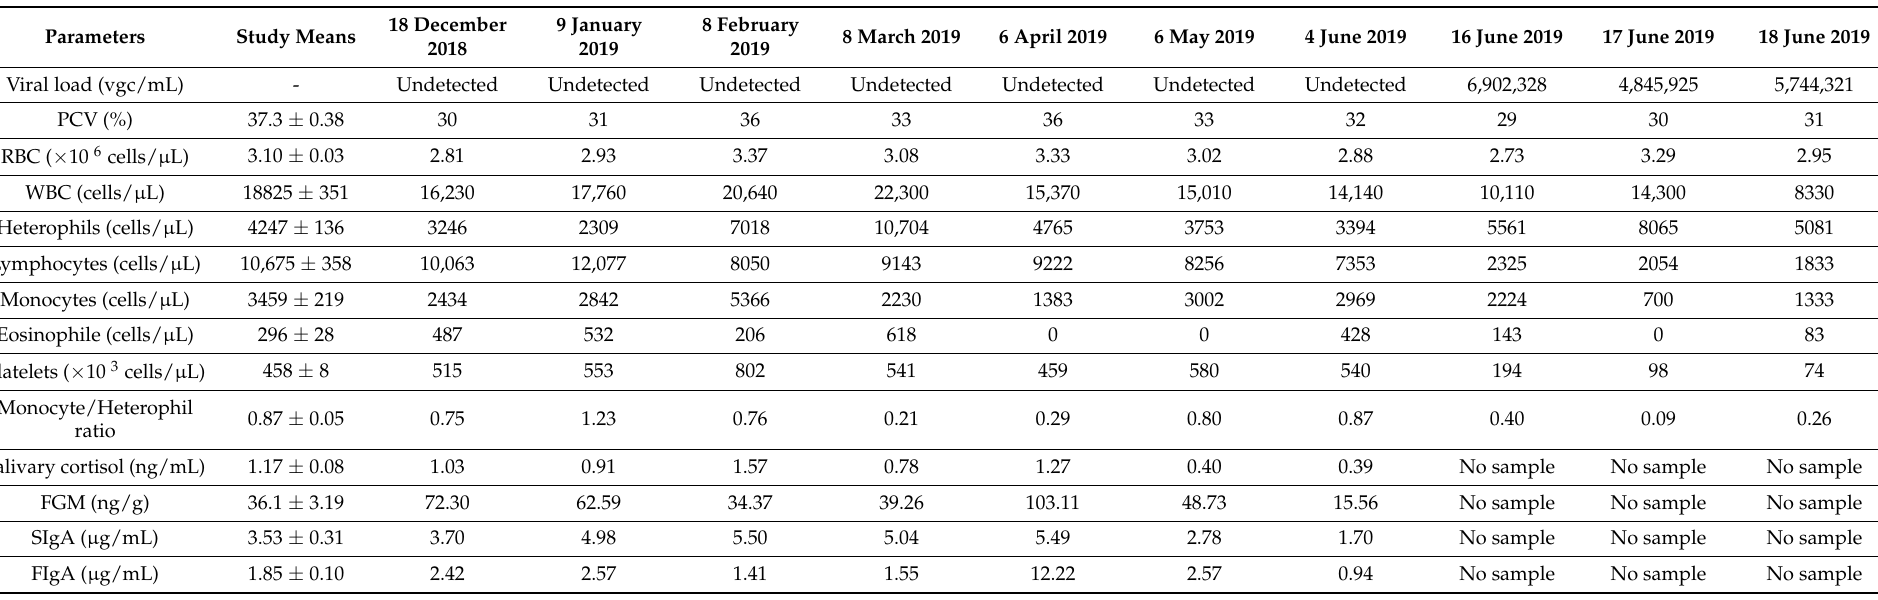
Table 2. Summary hematology values change, and stress indicators result in an elephant (E5) that developed clinical signs of EEHV-HD and died during the study period.